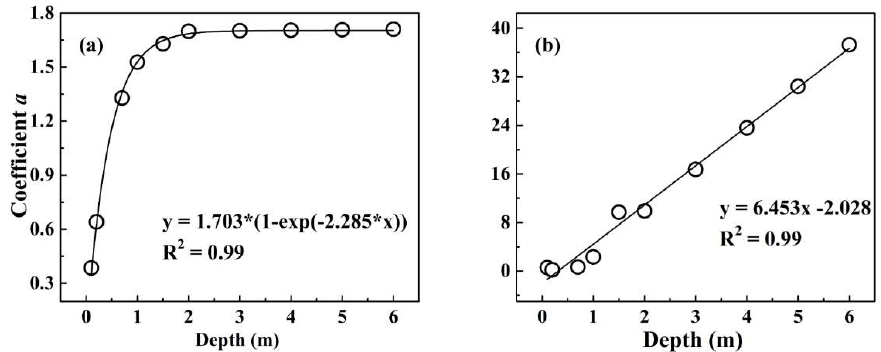
Figure 5. The relationship between ( a ) coefficient a , ( b ) coefficient b and water depth. The black line refers to the fitting line. The corresponding formulas are shown in each figure.